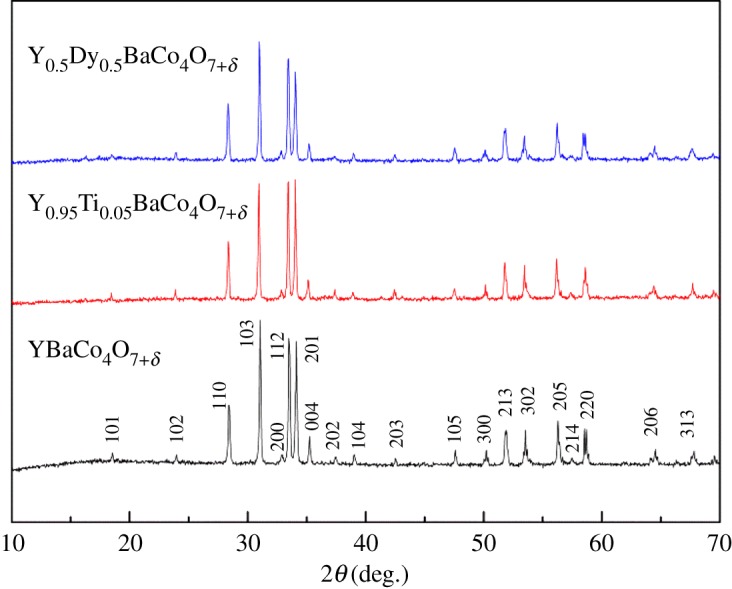
The XRD of the YBaCo4O7+δ, Y0.95Ti0.05BaCo4O7+δ and Y0.5Dy0.5BaCo4O7+δ samples.